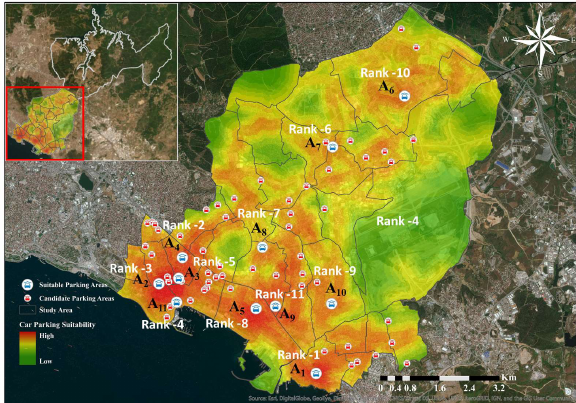
Figure 8. Ranking alternative car parking areas for Pendik / Istanbul